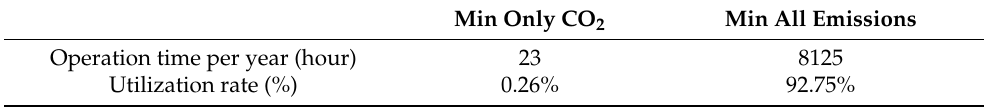
Table 2. Utilization rates and operation times for minimizing